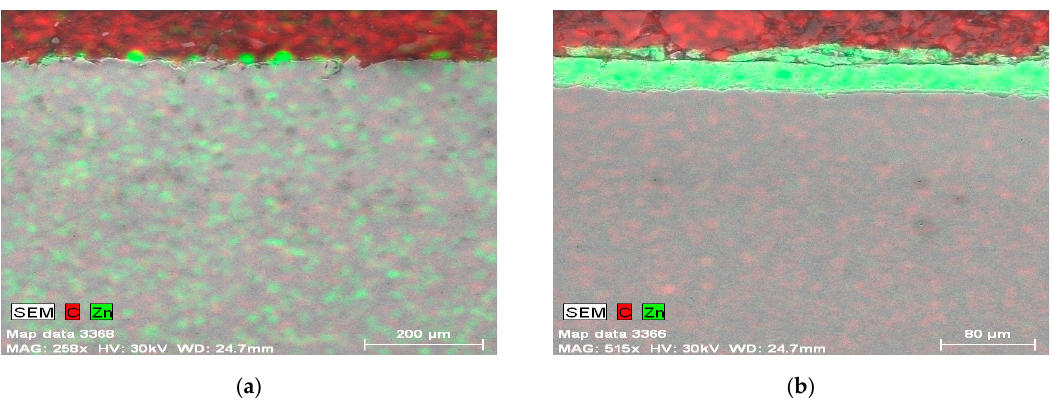
Figure 9. Chemical maps of compacted wire: ( a ) position 1, ( b ) position 4.